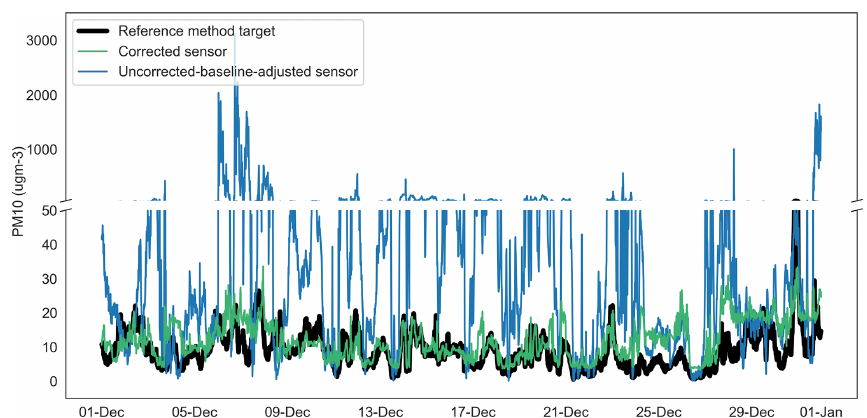
Figure 13. Time series of uncorrected-baseline-adjusted sensor, fully corrected sensor and reference method observations for PM 10 at Oxford St Ebbe’s (unseen data) for December 2020. ugm-3: µgm − 3 . Table 6. Expanded-uncertainty estimates for fully corrected sensor observations using the RFR validation dataset (the target values are the target expanded-uncertainty criteria recommended by European legislation). Pollutant Expanded Fully and finally corrected R 2 Conformance with uncertainty expanded uncertainty ∗ value target expanded- uncertainty objective NO 2 21% 17% 0.86 True, ≤ 25% PM 10 40% 15% 0.79 True, ≤ 50% PM 2 . 5 19% 12% 0.91 True, ≤